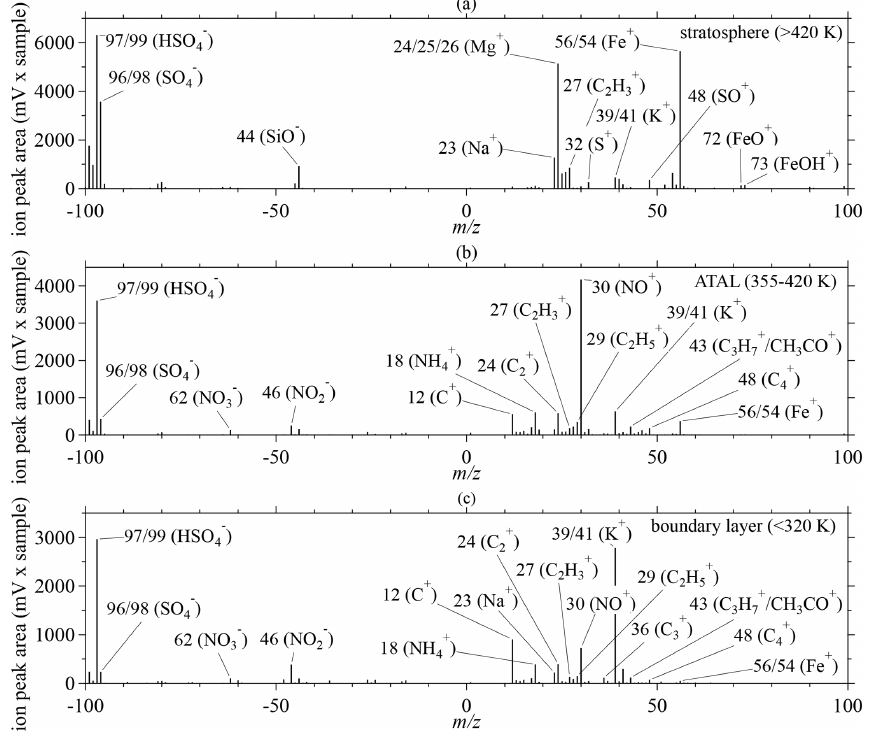
Figure 8. Bipolar mean spectra of the ERICA-LAMS particles containing primary components (Primary/Mixed Type): (a) in the stratosphere (averaged over 22493 particles), (b) in the ATAL (averaged over 16061 particles), and (c) in the boundary layer (averaged over 12044